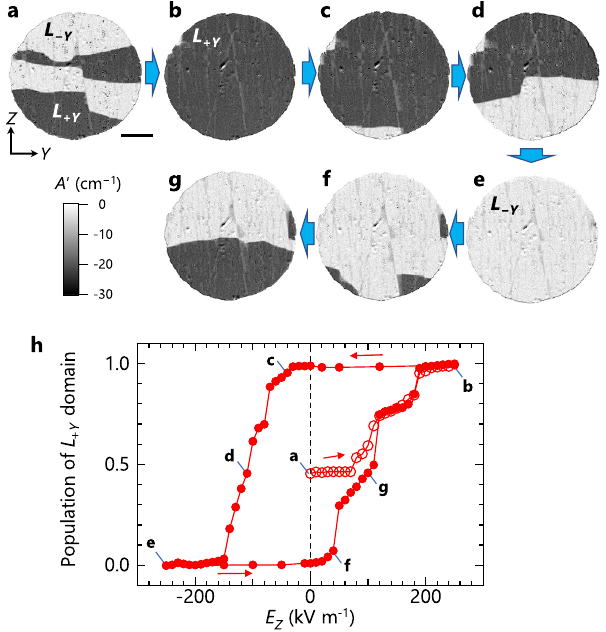
Fig. 4 Visualization of the Néel vector reversal with an electric fi eld. a – g Selected A ʹ images of an X -plane sample for k X > 0 at 43.7 K (< T N ) in a cyclic electric fi eld ( E Z = 0 → + 250 → − 250 → + 250 kV m − 1 ) with a constant bias magnetic fi eld ( μ 0 H Y = 0.15 T). Here, A ʹ is the variation of absorption coef fi cient from 50 K (> T N ). Dark and bright regions correspond to L + Y and L − Y domains, respectively. Scale bar below ( a ) is 0.2 mm. h The E Z dependence of population of L + Y domains derived from the areal ratio of dark and bright regions in a series of A ʹ images. The data points with alphabets ( a – g ) correspond to the images ( a ) – ( g ),